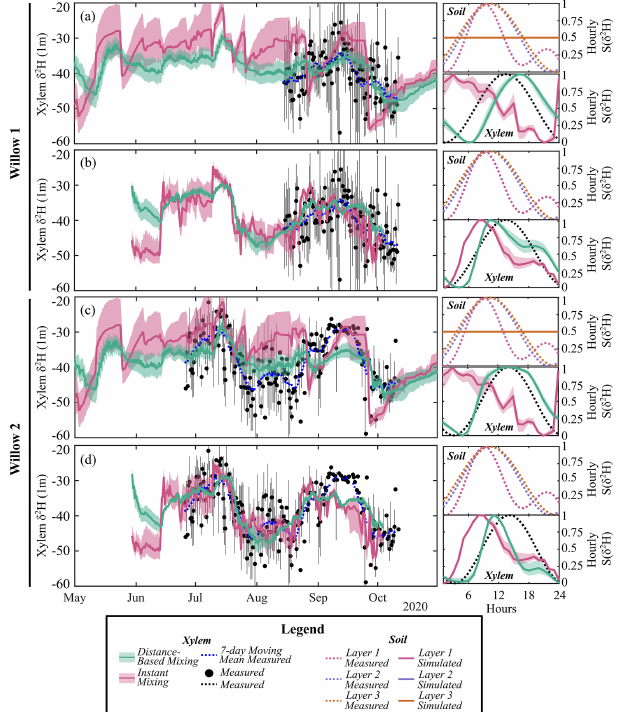
Figure 6. Simulated 12h average xylem deuterium using (a) simu- lated and (b) measured soil deuterium with distance-based and in- stant mixing in Willow 1. Simulated 12h average xylem deuterium using (c) simulated and (d) measured soil deuterium with distance- based and instant mixing in Willow 2. Measurement bars represent the maximum and minimum measured xylem water isotopes during the 12h period. For each simulation, standardized sub-daily δ 2 H ( S(δ 2 H ) ) shows the measured and simulated soil (cell-contribution- weighted average) and xylem average hourly variability. Note that standardized simulated soil water isotopes overlap for all soil layers.